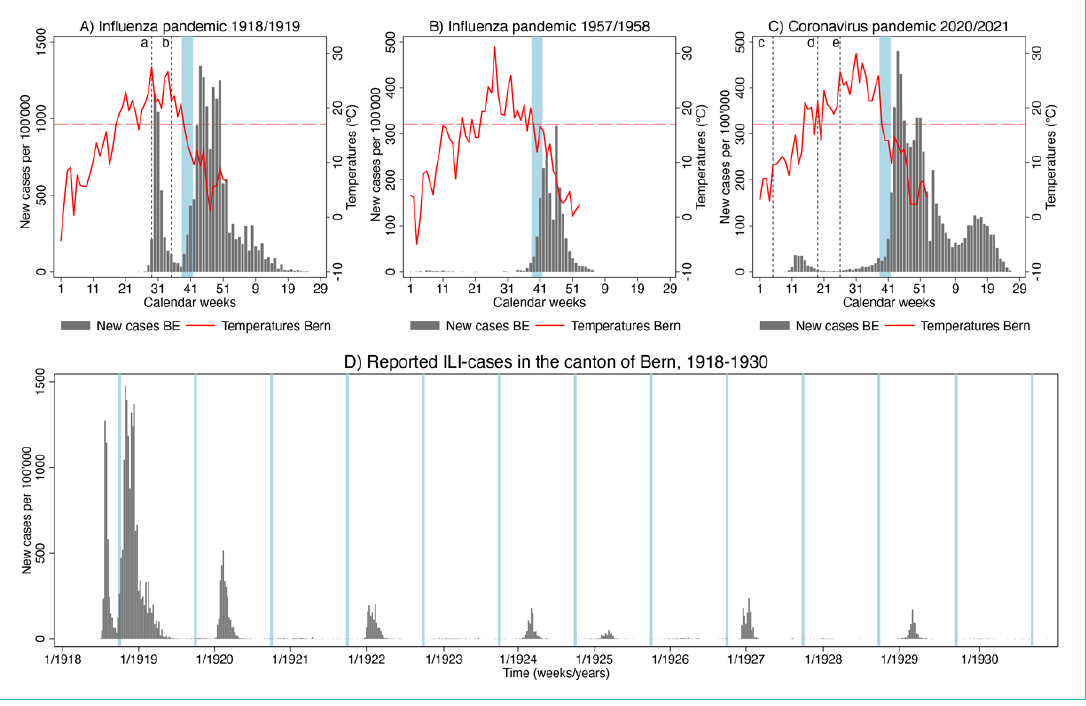
Figure 1: Weekly totals of newly reported cases per 100,000 inhabitants of influenza-like-illness (ILI) in 1918/1919 (A [5]) and 1957/1958 (B), and laboratory-confirmed SARS-CoV-2 infections in 2020/2021 (C) in the Canton of Bern (BE), plotted against weekly averages of daily maxi- mum temperatures in the City of Bern (red lines, the dotted reference lines indicate 17 ℃ ). (a) Reporting obligation introduced; (b) complete lift- ing of all measures after first wave; (c) reporting obligation introduced; (d) change of testing strategy:aAll people with symptoms should get tested; (e) Complete lifting of all measures after first wave. (D) Weekly totals of physician-reported new cases of influenza-like-illness (ILI) in the canton of Bern, 1918-1930 [5]. Blue shaded area: Calendar weeks